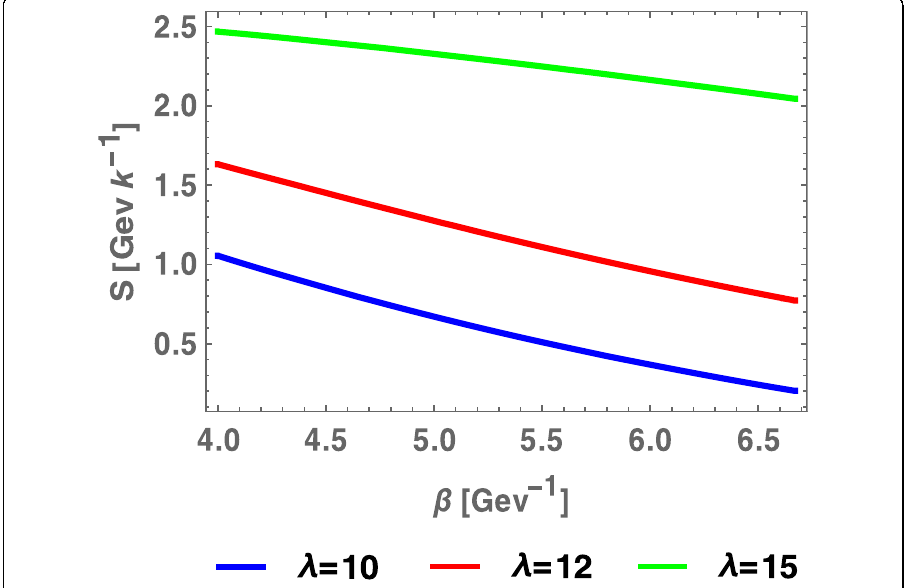
Fig. 9 Entropy S is plotted against β for different values